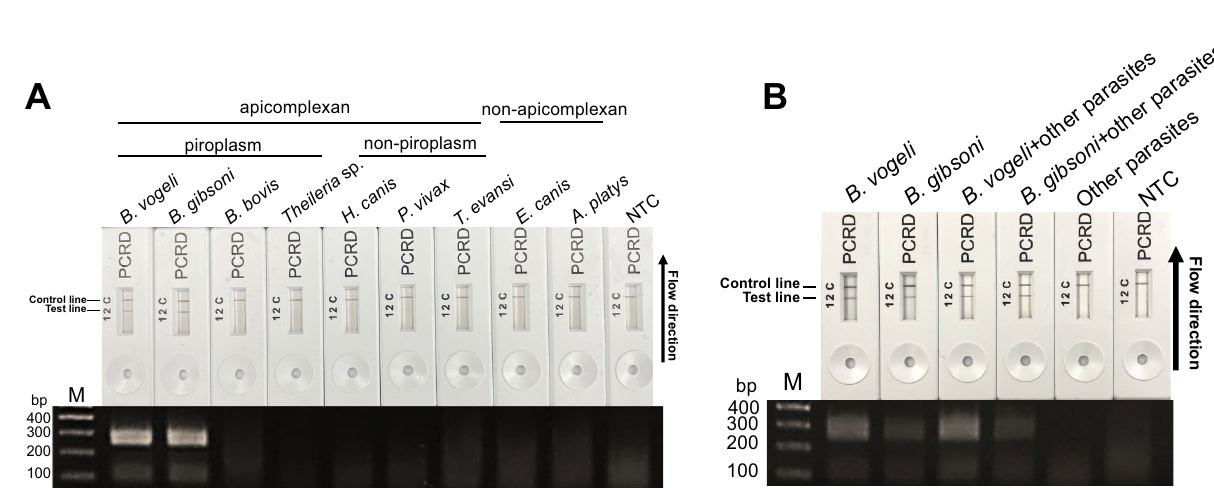
Figure 4. Specificity of the RPA-LFD assay using rpaBab264 for Babesia spp. detection and DNA samples of piroplasms, other apicomplexans and non-apicomplexans. The performance of RPA-LFD assay using rpaBab264 was detected by single species per a reaction ( A ) and multiple species per a reaction ( B ). NTC represents the negative control (nuclease-free